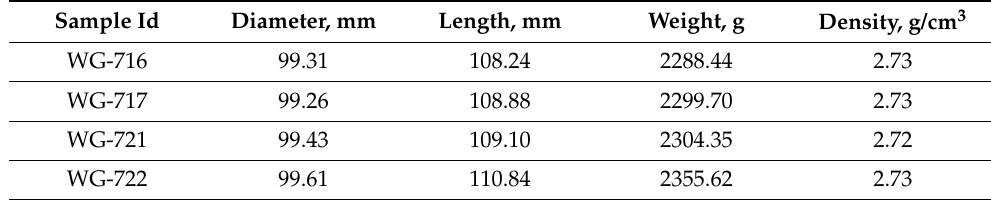
Table 2. Geometrical parameters of